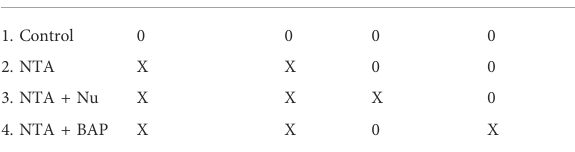
TABLE 1 Experimental design for control and treatment groups. Chemical application is indicated with X and absence of chemical application is indicated with